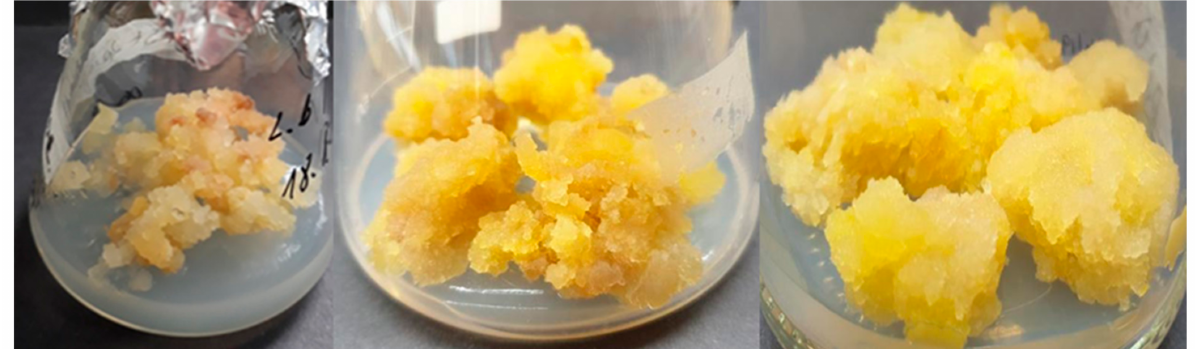
Figure 3. Leaf-derived callus of Linnaea borealis var. borealis cultured on MS medium enriched with picloram 2.0